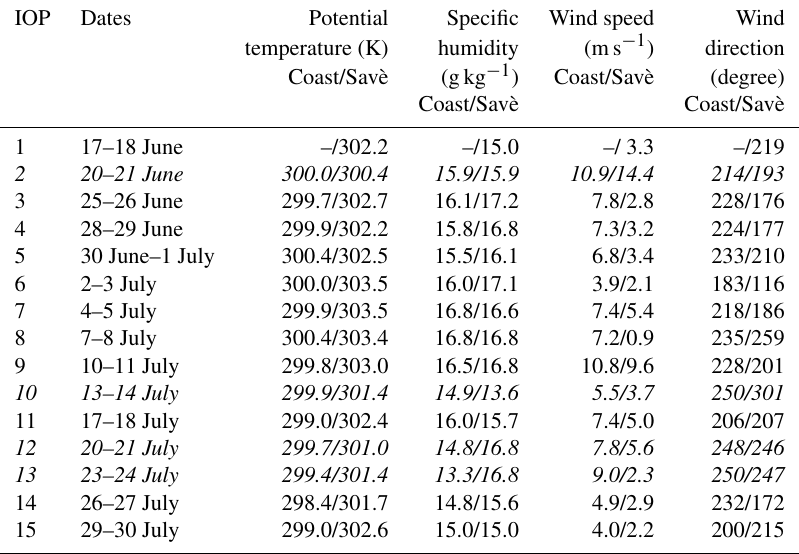
Table 1. IOP numbers; corresponding dates; and mean potential temperature, specific humidity, horizontal wind speed and wind direction in the lower 1000m at the coast and Savè during the DACCIWA ground-based field campaign. Values are obtained from the radiosoundings in the late afternoon and averaged for all three coastal stations if available. IOPs not used in this study are written in italic